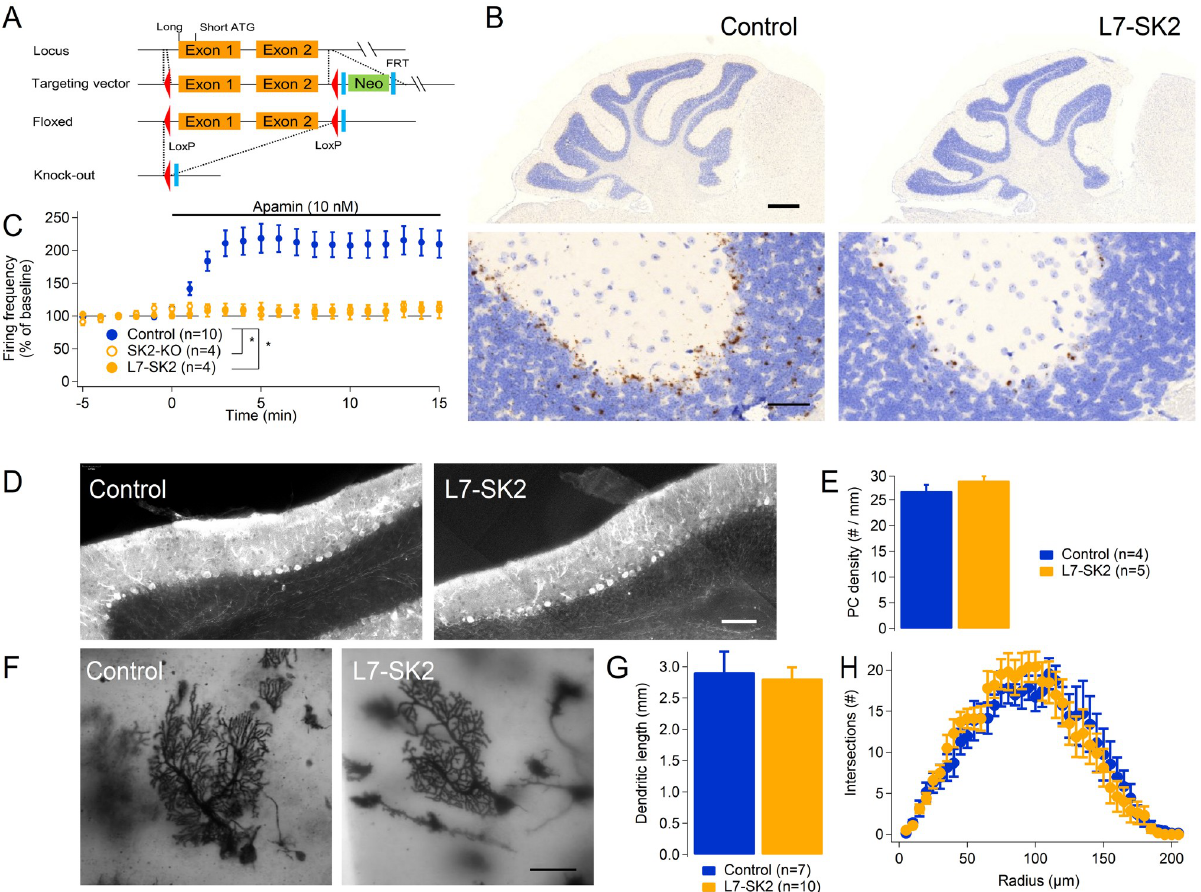
Fig 1. The L7-SK2 mutant: Generation and morphology. (A) A conditional mutation was generated with the CRE-Lox system introducing LoxP sites flanking the first two coding exons of the Kcnn2 locus, coding for SK2 (both long and short isoforms). A downstream Neo cassette—flanked by FRT sequences—was used in the targeting vector as a reporter during the selection of recombinant embryonic stem cell clones and removed by crossing mutant mice with a mouse strain with constitutive expression of the FLP recombinase. The resulting “floxed” mouse strain was crossed with L7-CRE mice, expressing the CRE recombinase in a PC-specific way to obtain PC-specific KO (L7-SK2). (B) In situ hybridization performed by RNAscope revealed a virtually complete absence of the Kcnn2 mRNA in the PC layer (right panels) compared to floxed control littermates. The gross morphology and foliation did not show evident alterations (scale bar: 500 μ m and 50 μ m in the upper and lower panels, respectively). (C) The absence of functional SK channels was tested for sensitivity to the selective SK channel agonist apamin (10 nM). The graph shows the firing frequency of PCs evoked by a somatic depolarizing current injection of fixed amplitude before and after the administration of the drug in the bath (a negative bias current was injected to prevent spontaneous firing). Only control cells increased their firing frequency in response to the drug, while both SK2-KO and L7-SK2 did not show any significant change in firing frequency, confirming the absence of SK2 channels and of other apamin-sensitive channels. (D) PC density assessed on sections stained with anti-calbindin antibody (scale bar: 100 μ m) was comparable in L7-SK2 mice and control littermates. (E) Bar graph showing the PC density in control and L7-SK2 mice. (F) Golgi-stained PCs in control (left) and L7-SK2 mice (right; scale bar: 50 μ m). (G) Bar graph showing the total length of the PC dendritic tree in control and L7-SK2 mice. (H) Sholl analysis showed no significant difference in the morphology of PCs from L7-SK2 and control mice. � p < 0.05. See also S1 Fig. CRE, causes recombination; FLP, flippase; FRT, FLP recombinase target; Kcnn2 , potassium calcium-activated channel subfamily N member 2; KO, knockout; LoxP, locus of X-over of P1; PC, Purkinje